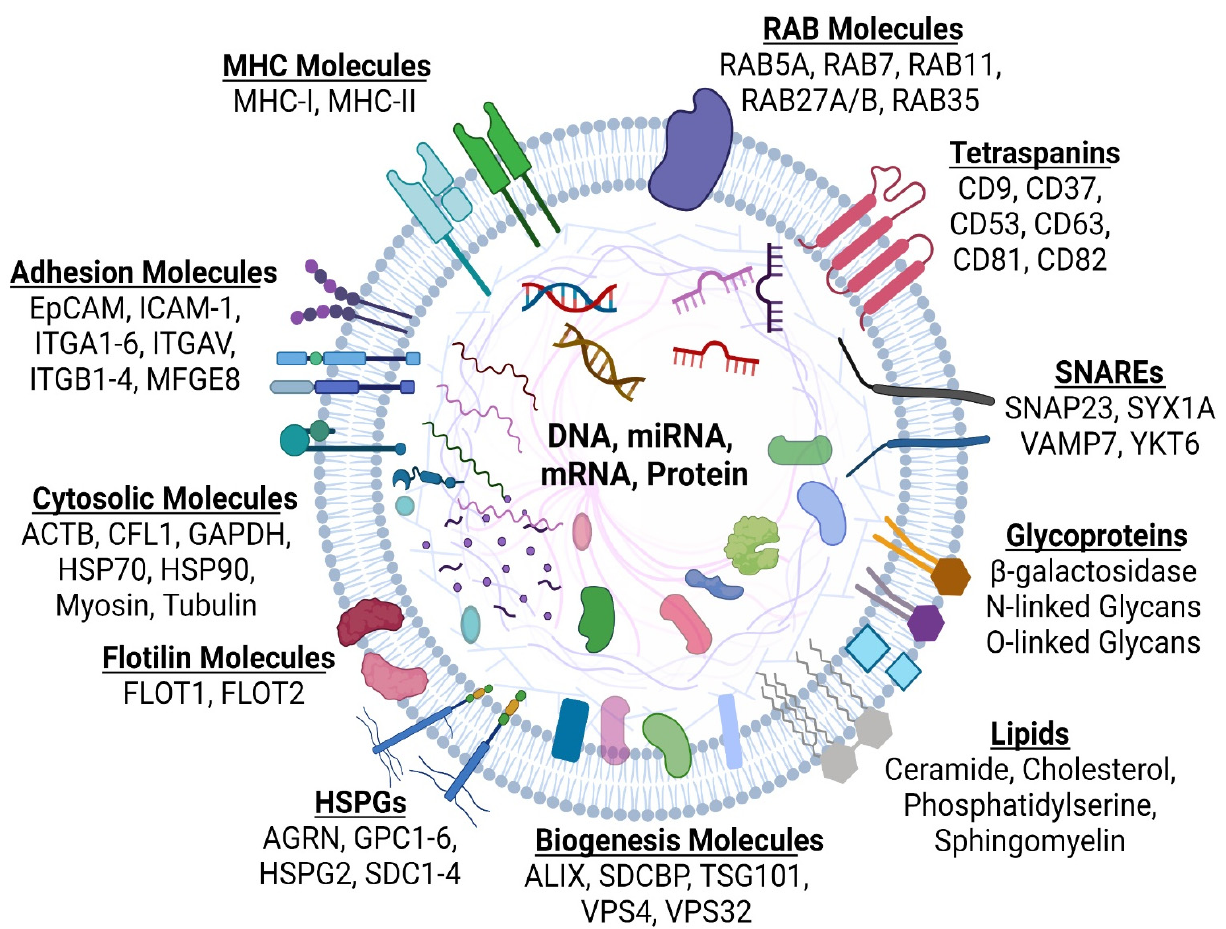
Figure 3. Typical structure and molecular composition of exosomes. Exosomes are surrounded by a phospholipid bilayer enriched in lipids such as ceramide, cholesterol, phosphatidylserine, and sphingomyelin. They are enriched in glycoproteins such as β -galactosidase, and N-linked or O-linked Glycans. Exosomes are enriched in proteins associated with biogenesis, such as programmed cell death 6-interacting protein (ALIX), syntenin-1 (SDCBP), tumor susceptibility gene 101 (TSG101), and vacuolar protein sorting 4 and -32 (VPS4 and VPS32). Upon trafficking of multi-vesicular bodies encompassing exosomes, they express small GTPase Ras-related proteins 5A, -7, -11, -27A/B and -35 (RAB5A, RAB7, RAB11, RAB27A/B, and RAB35). When MVBs fuse with the plasma membrane to release exosomes into the extracellular space, they also express soluble N -ethylmaleimide-sensitive fusion attachment protein receptor (SNARE) proteins such as synaptosome associated protein 23 (SNAP23), syntaxin1a (SYX1A), vesicle associated membrane protein 7 (VAMP7), and YKT6 V- SNARE Homolog (YKT6). Exosomes are enriched in; tetraspanin proteins, such as CD9, CD37, CD53, CD63, CD81, and CD82; flotillin (FLOT) molecules, such as FLOT1 and FLOT2; major histo- compatibility complex-I and -II (MHC-I and -II); adhesion molecules for example epithelial cellular adhesion molecule (EpCAM), intercellular adhesion molecule-1 (ICAM-1), integrin subunit α 1-6 (ITGA1-6), integrin subunit α V (ITGAV), integrin subunit β 1-4 (ITGB1-4), and lactadherin (MFGE8); heparan sulfate proteoglycans (HSPGs) that include agrin (AGRN), glypican 1-6 (GPC1-6), perlecan (HSPG2), and syndecan1-4 (SDC1-4). Exosomes can also contain cytosolic proteins that include actin (ACTB), cofilin1 (CFL1), glyceraldehyde 3-phosphate dehydrogenase (GAPDH), heat shock protein 70 and -90 (HSP70 and HSP90), myosin, and tubulin. The exosomal surface molecular and internal cargo serves to mediate intracellular communication between different cell types within the body, thus functioning differently in either normal homeostasis or pathological conditions.